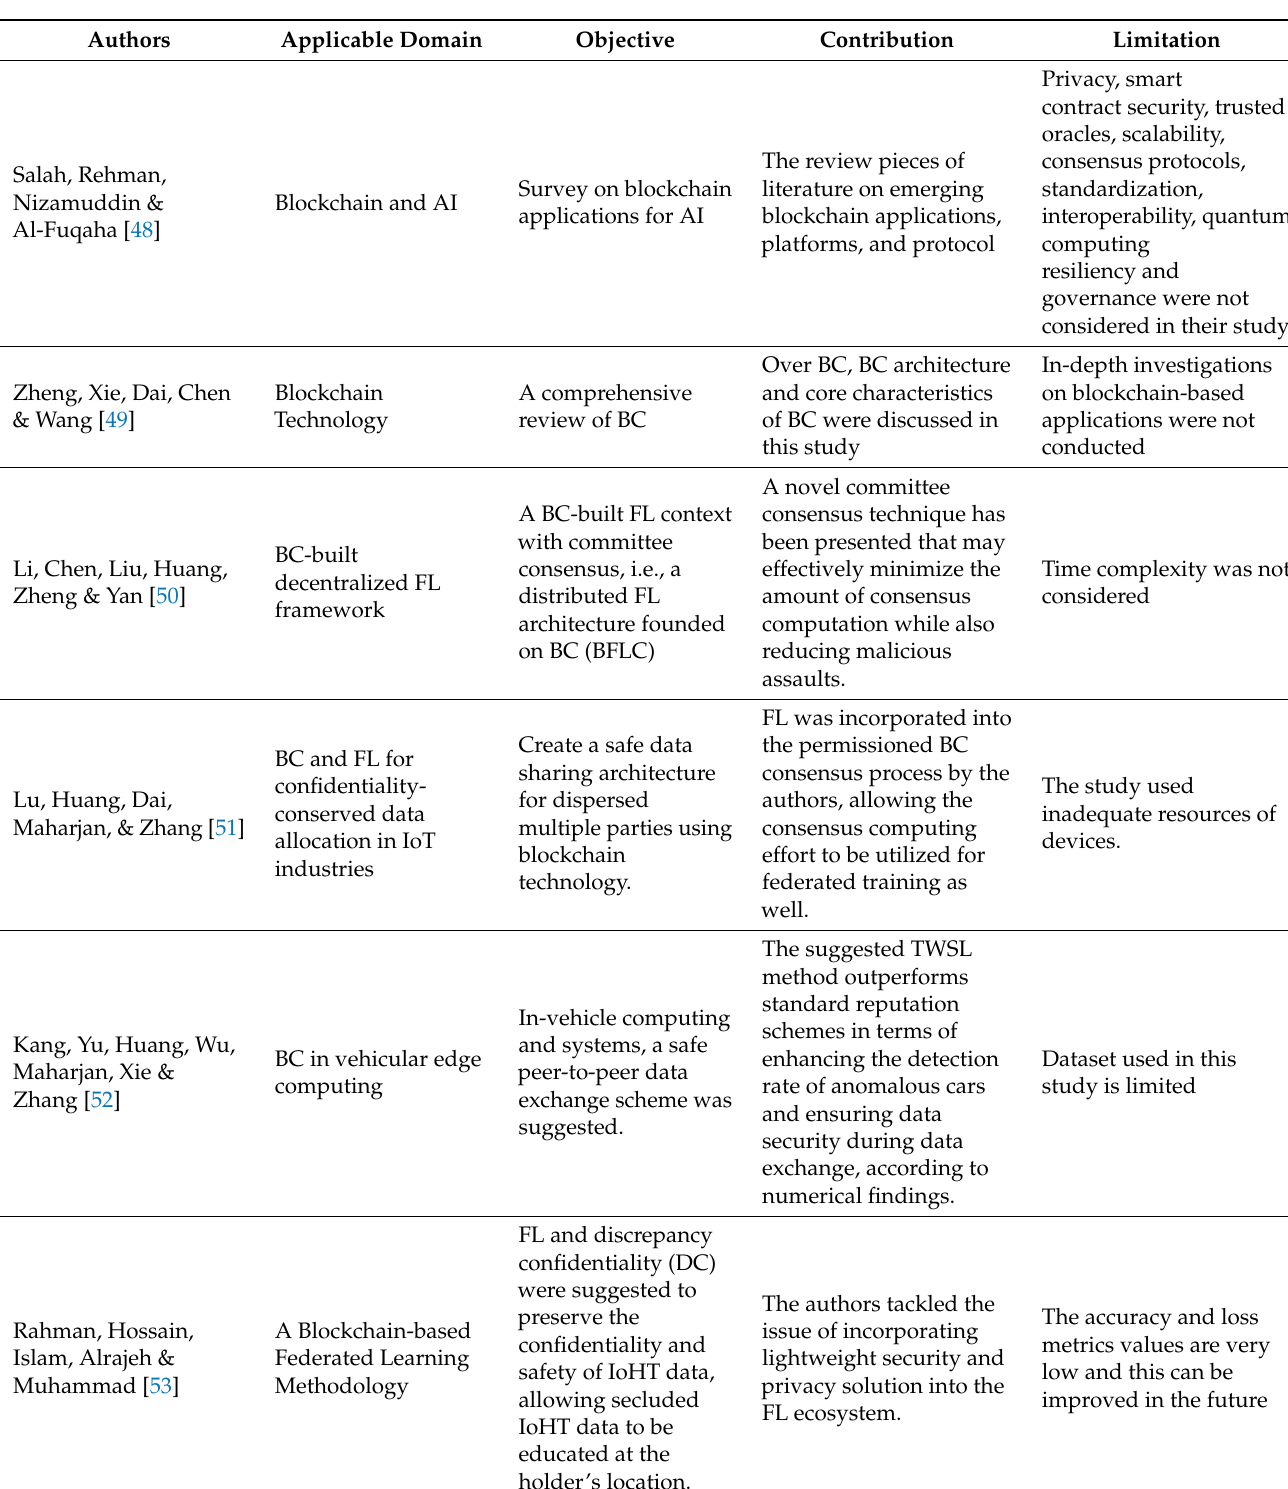
Table 10. Summary of research on the current state of data sharing in distributed systems in BC and